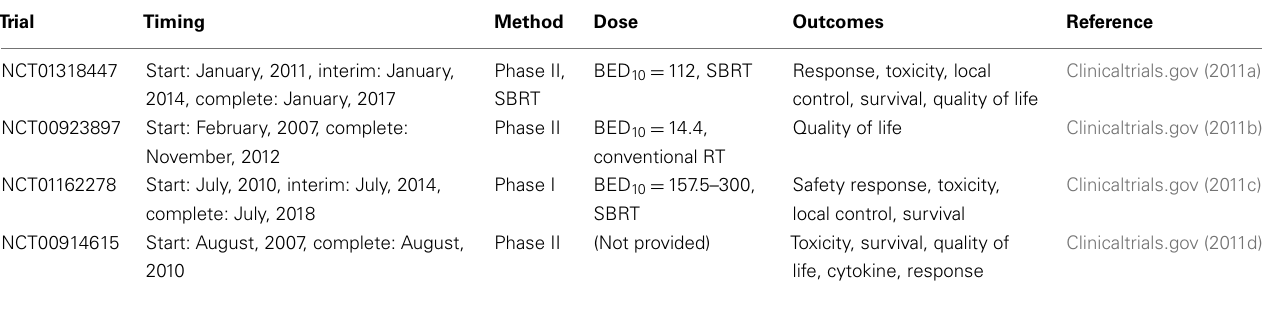
Table 3 | Ongoing clinical trials regarding radiotherapy in the treatment of liver metastases.